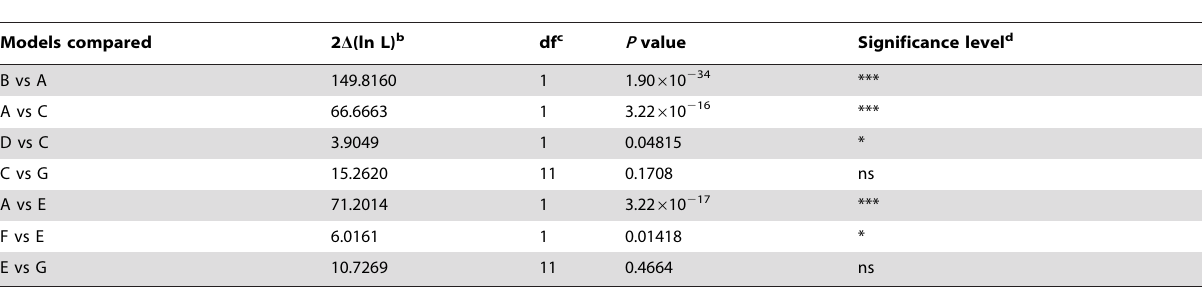
Table 5. Likelihood ratio tests of selective pressure on whale MOXD2 gene a .